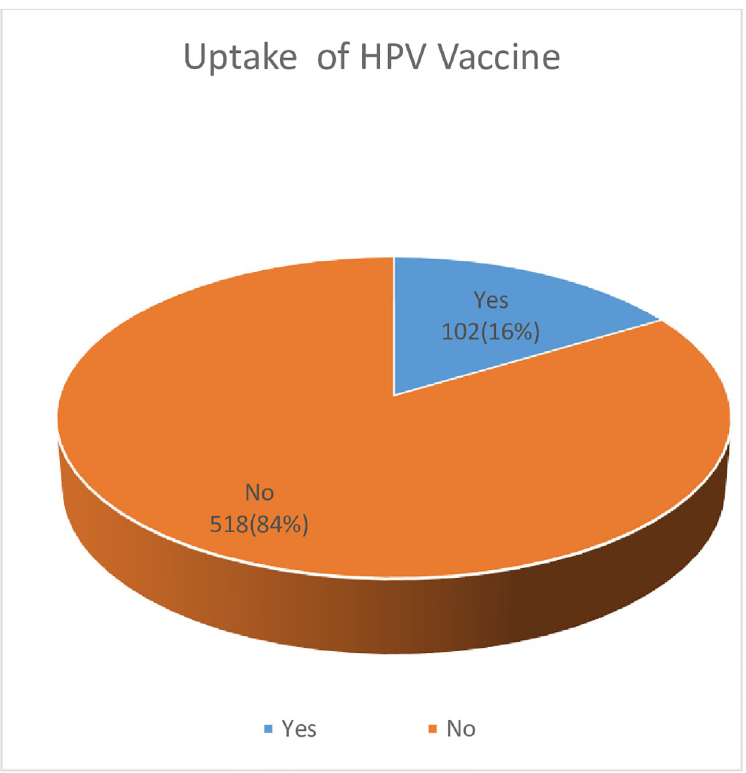
Fig 3. Uptake of HPV vaccine among female preparatory school students, Bahir Dra, Ethiopia, 2021.